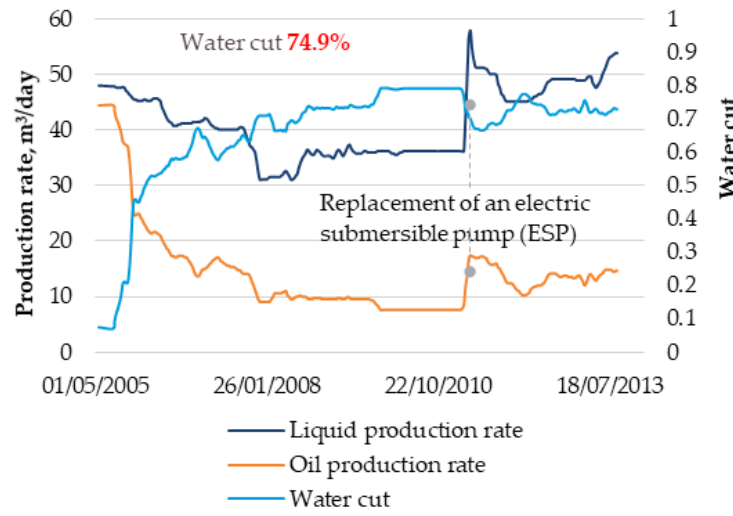
Figure 5. Change in the main field parameters for the well No. 13G [3].